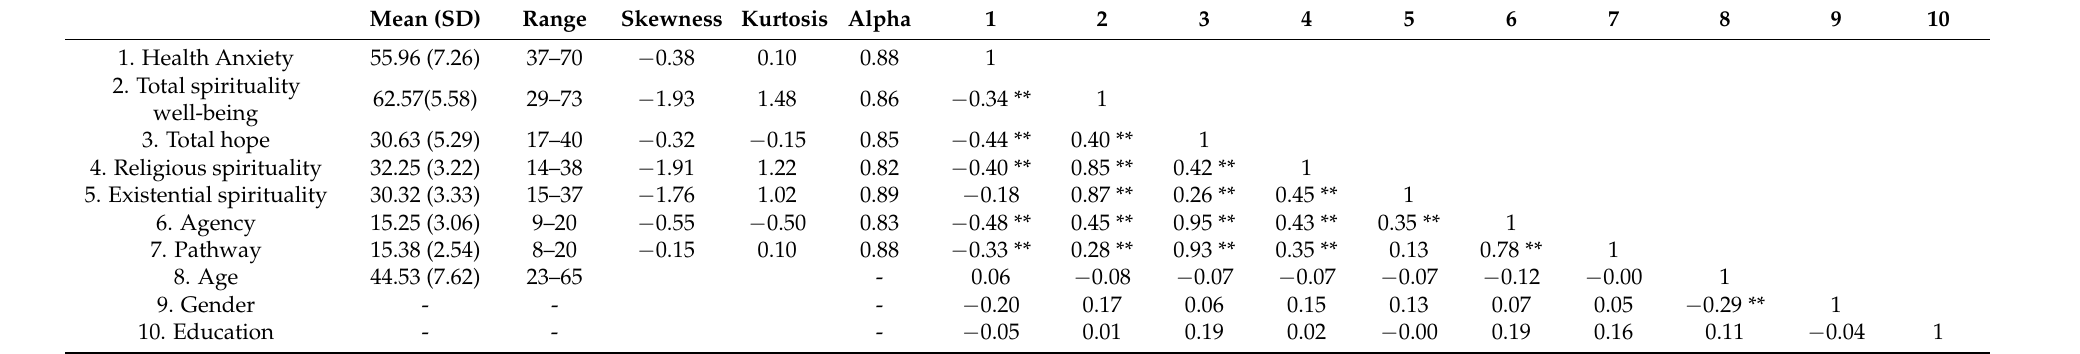
Table 1. Means, standard deviations, range, Cronbach alphas, and intercorrelation matrix of study variables.